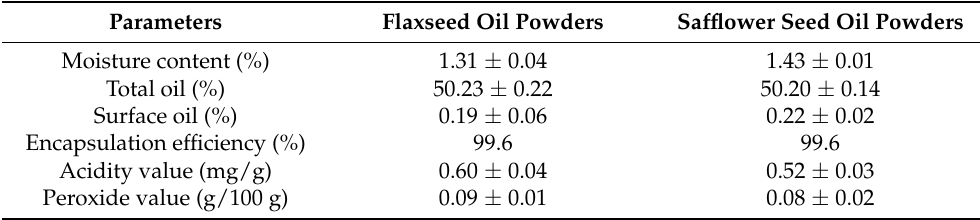
Table 5. Physicochemical properties of the flaxseed oil and safflower seed oil